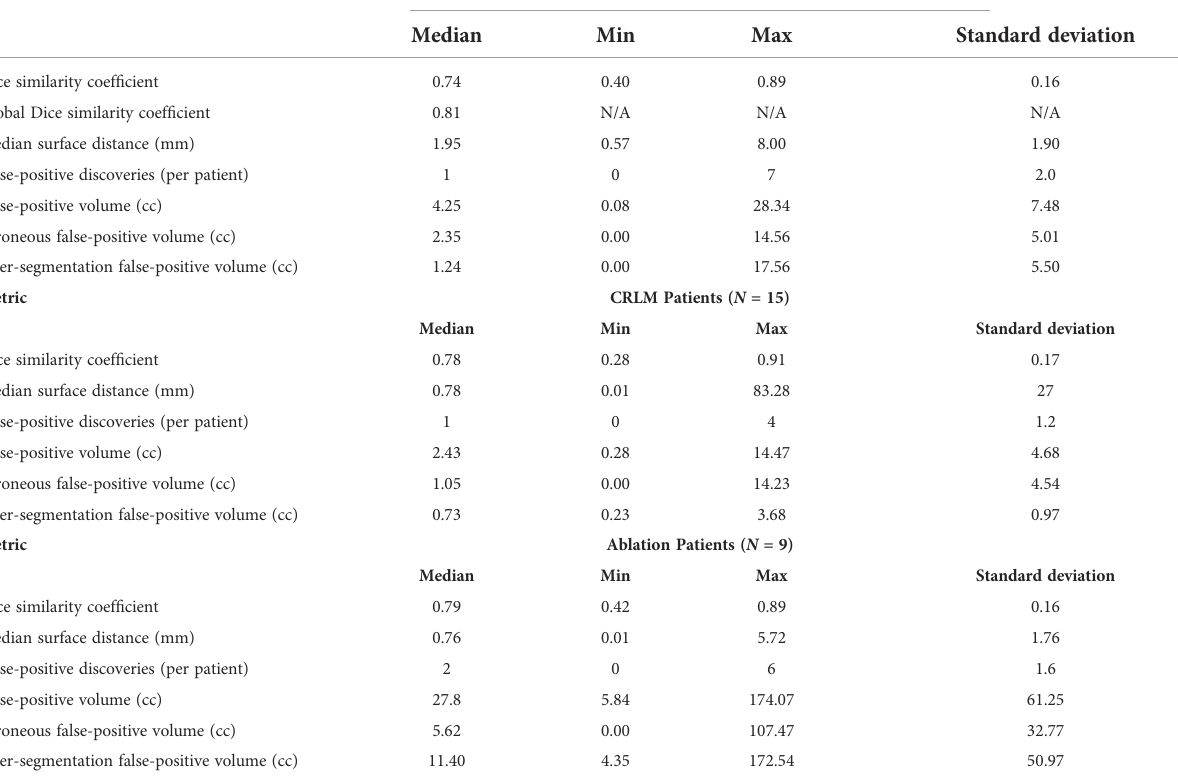
TABLE 4 Metrics of Dice similarity coef fi cient, median surface distance (mm), false-positive discoveries (per patient), and false-positive volume (cc) for 15 3D-IRCADb Test Patients. Metric